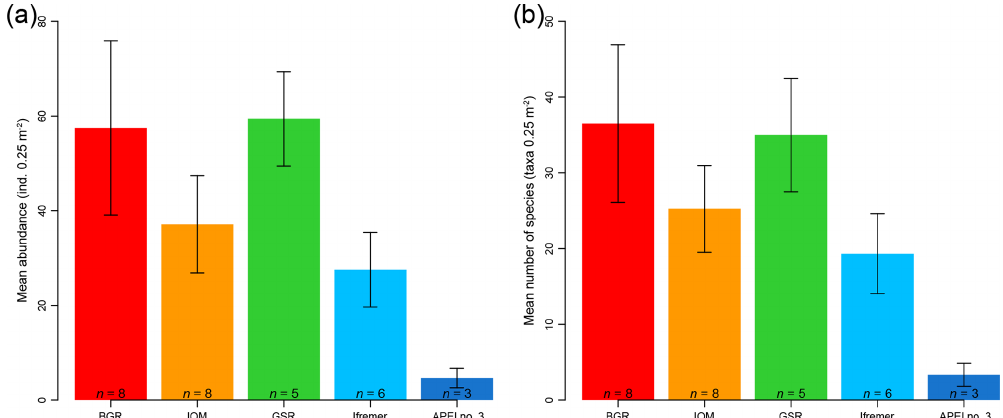
Figure 2. Bar plots of mean abundance per area (a) and mean species richness per area (b) of polychaete assemblages for each sampled area within the eastern CCFZ. n indicates the number of box cores samples. Error bars show the standard